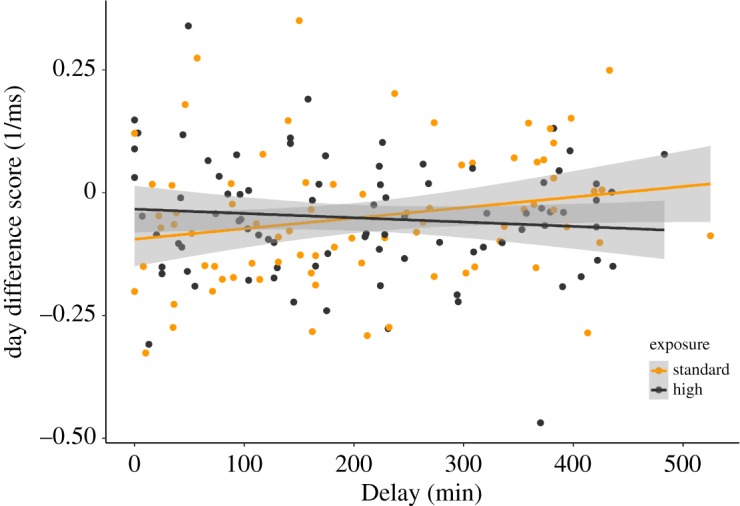
Scatterplot showing the correlation between Day Difference score (RTs on day 2 minus RTs on day 1, collapsed across Word Type condition) and Delay (in min) for each Exposure condition. Shaded areas represent 95% confidence intervals.